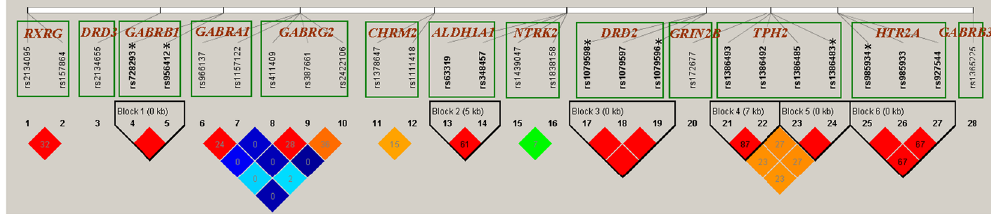
Figure 2. LD plot of 28 SNPs on 13 candidate genes. In the LD heat map, 13 genes are arranged according to their chromosomes. SNPs (RS numbers) within the same gene are arranged by physical positions and framed by a green rectangle. Pairwise LD of SNPs within the same gene was measured using D ′ and r 2 50 . The colored rhombus reflects the D ′ magnitude (higher LD, red) and the numbered rhombus indicates the r 2 value. SNPs with a strong LD are framed in a black inverse diamond block, which is defined according to the confidence interval method 51 . Six SNPs with a star sign concatenated with the RS number are removed from the subsequent analysis because of a complete LD and/or HWE